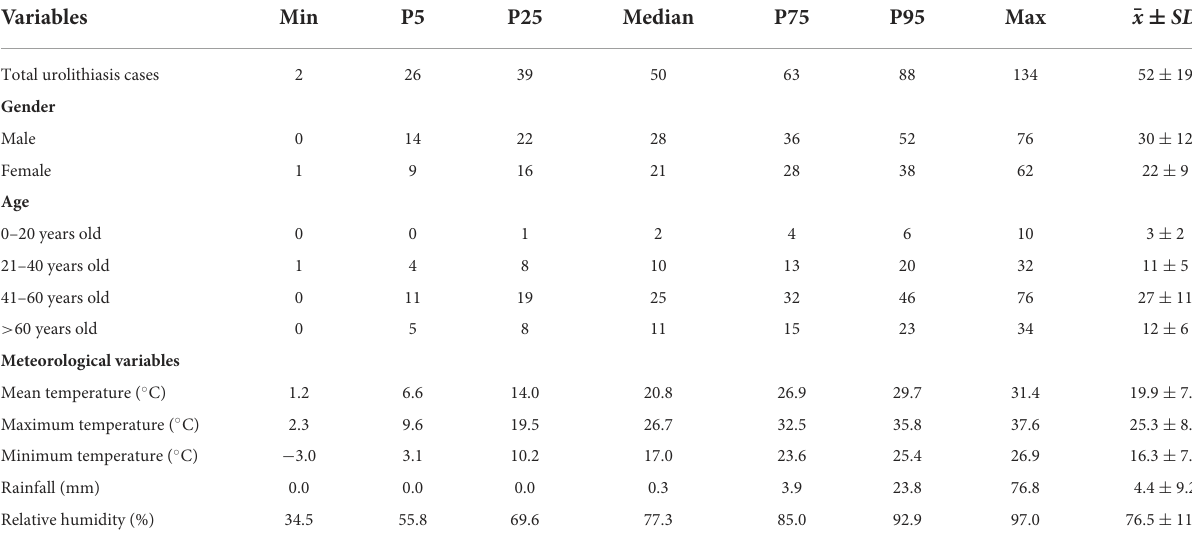
TABLE 1 Summary of daily urolithiasis hospitalizations and meteorological variables in Ganzhou from 2018 to